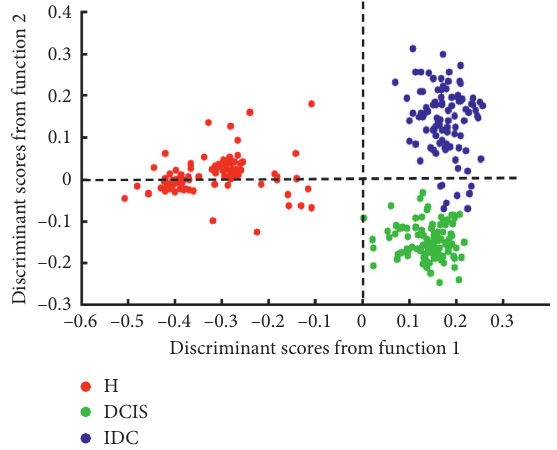
Figure 5: The scatter plot of linear discriminant scores for three types of